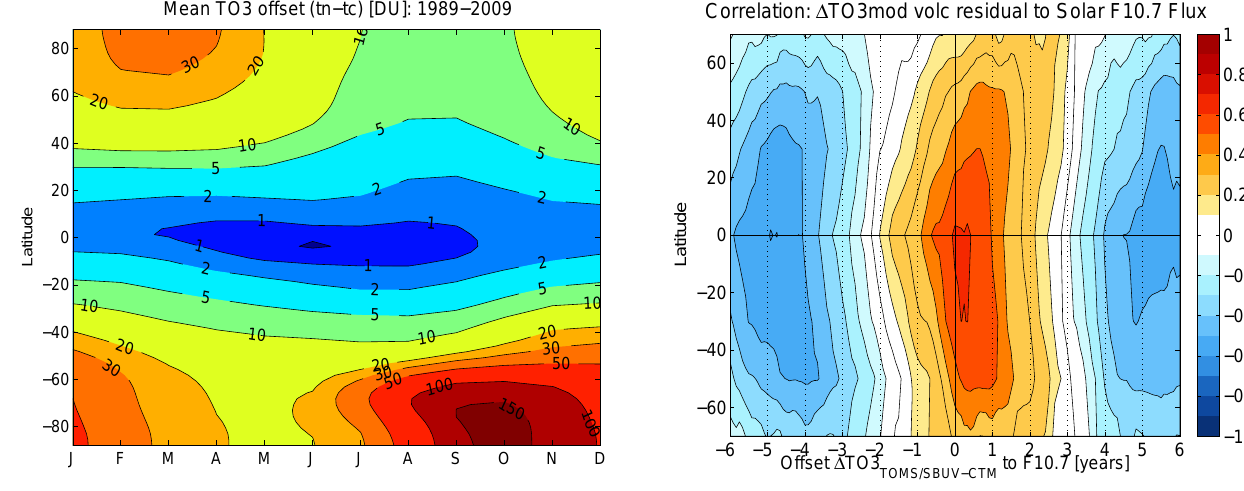
Fig. 5. Correlation between the residuals of the “aerosol only” re- gression of TOMS / SBUV − tt offsets and the Solar F 10 . 7 radio flux, for different time delays between 1 TO3 and F 10 . 7 . The regressed time series is shown in Fig.